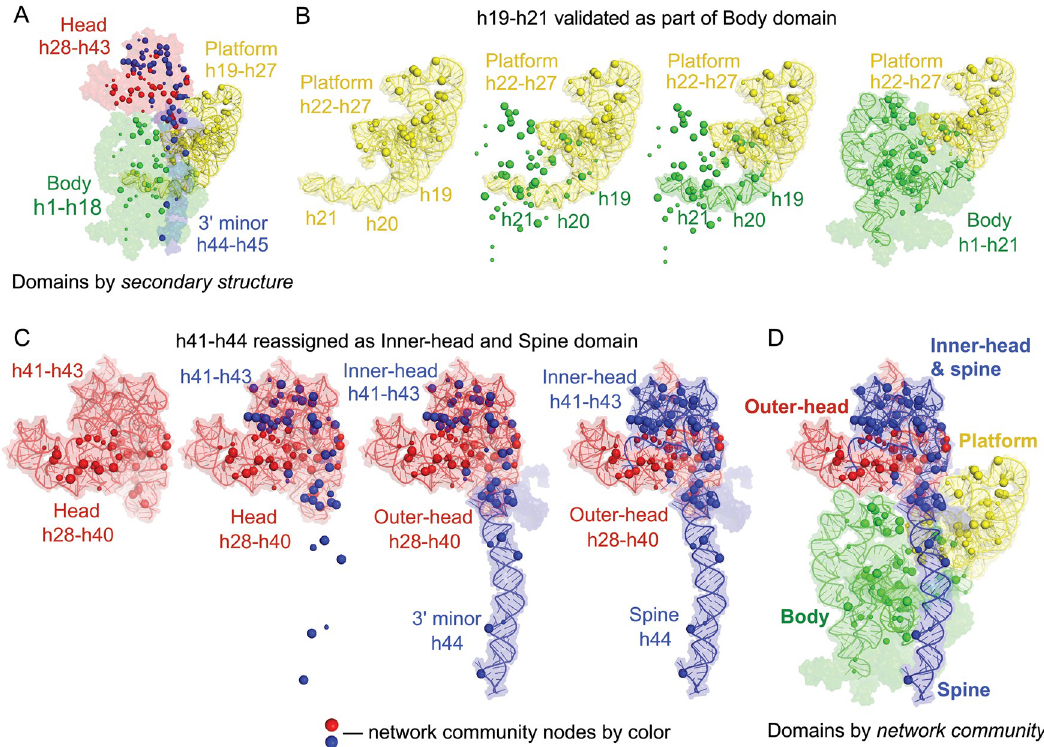
Fig 4. Domain architecture of the 16S rRNA as defined by network communities. Spheres indicate strong network nodes, colored by community. (A) 16S rRNA domain architecture based on secondary structure. Note that part of the central (platform) domain, as defined by the 16S rRNA secondary structure, is a structural component of the body. (B) Network communities correctly define the body domain and the more compact platform domain (yellow). These domains emerged naturally from the network analysis, even though no three-dimensional structural information was included in the network analysis. (C) The conventional head domain contains two RING network communities occupying distinct regions, defined here as the outer-head domain (red) and the inner- head and spine domain (blue). (D) Small-subunit domain model based on RING network communities in the 16S rRNA. The domains shown correspond to RING-MaP network community nodes of high correlation observed for the +Spc (+Rif) treatment condition; however, the same communities are observed in the absence of Spc. Rif, rifampicin; RING, RNA interaction group; RING-MaP, RNA interaction groups analyzed by mutational profiling; rRNA, ribosomal RNA; Spc,